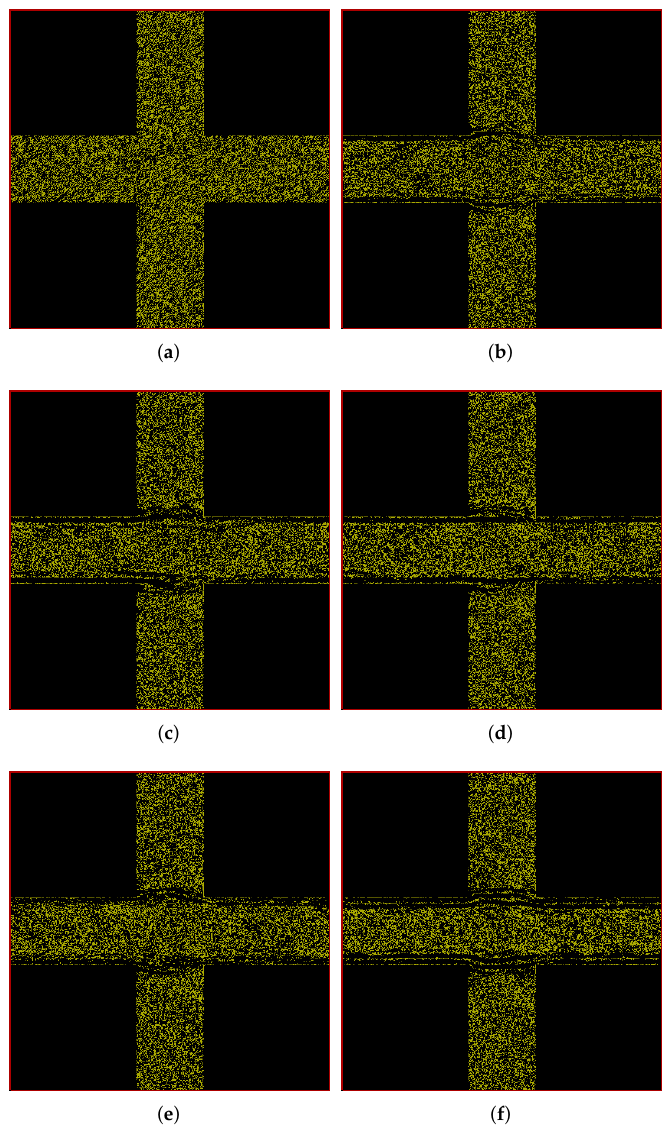
Figure 6. Snapshots of simulation (in porous-media-view) at different times showing development of polymer positions over time for flow through a cuboidal porous medium with pressure applied in the positive x direction. ( a ) t = 0 s; ( b ) t = 25 s; ( c ) t = 50 s; ( d ) t = 100 s; ( e ) t = 150 s; ( f ) t = 200